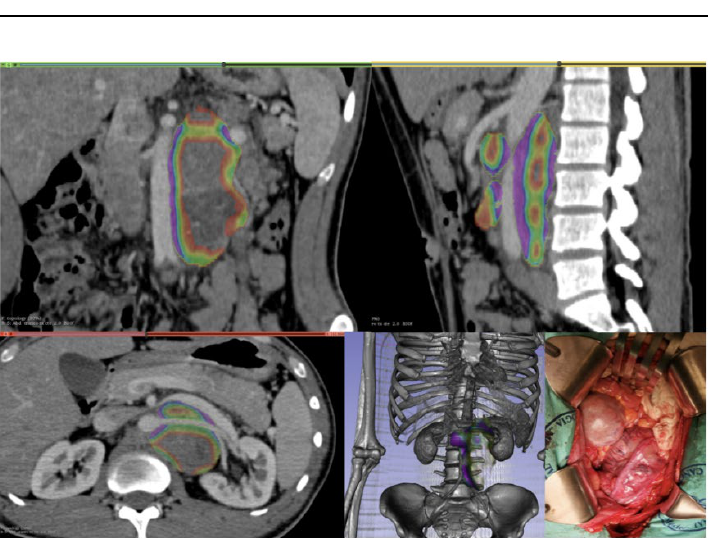
Figure 1. Para-aortic mass, with CT-rendering and 3D reconstruction view precise relationship with aorta and posterior abdominal wall; the mass was completely resected without requirement of resection or reconstruction vascular.